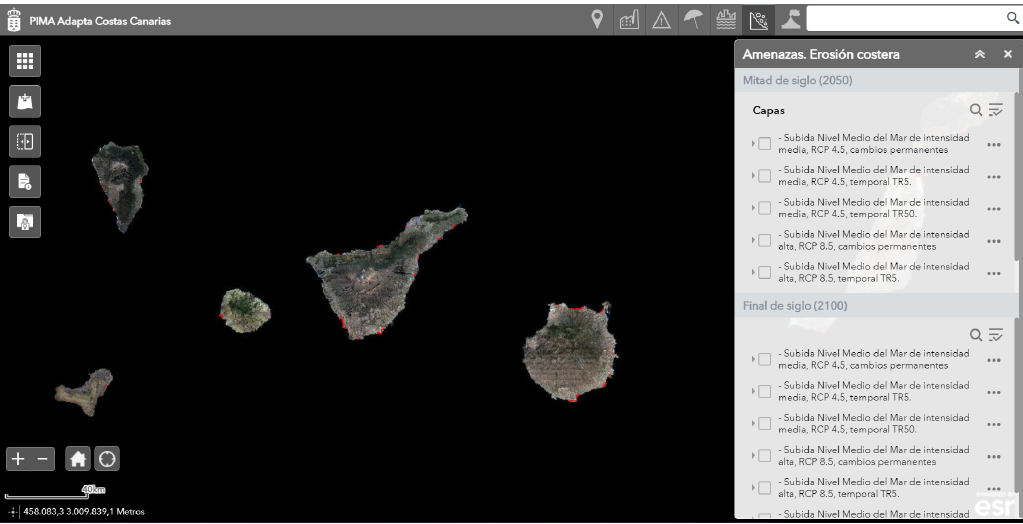
Figure A5. Overview of the resource. Source: GRAFCAN (2022a).